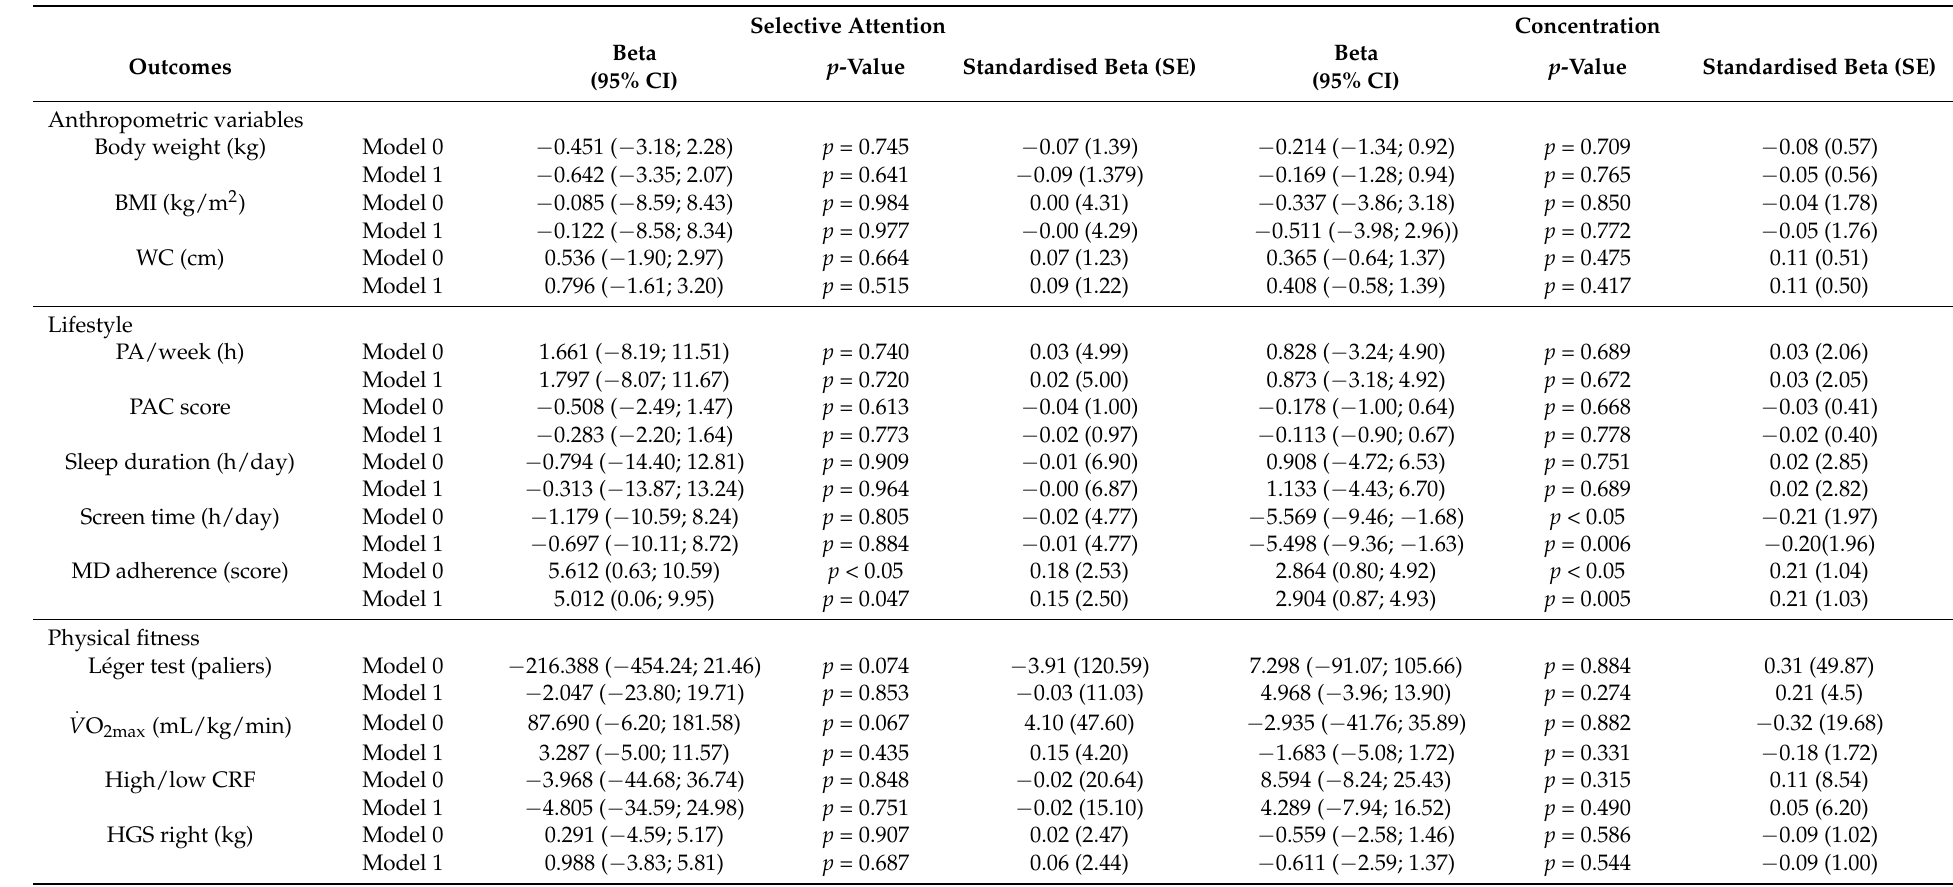
Table 2. Association of selective attention and memory score with sociodemographic, anthropometric, lifestyle and fitness variables in schoolchildren. Selective Attention